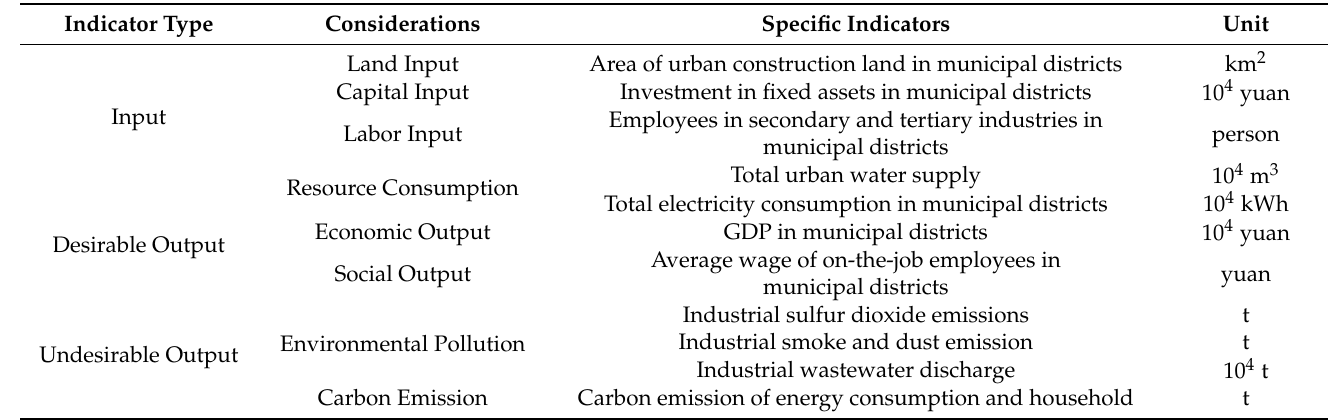
Table 1. Evaluation index system of GLUE in resource-based